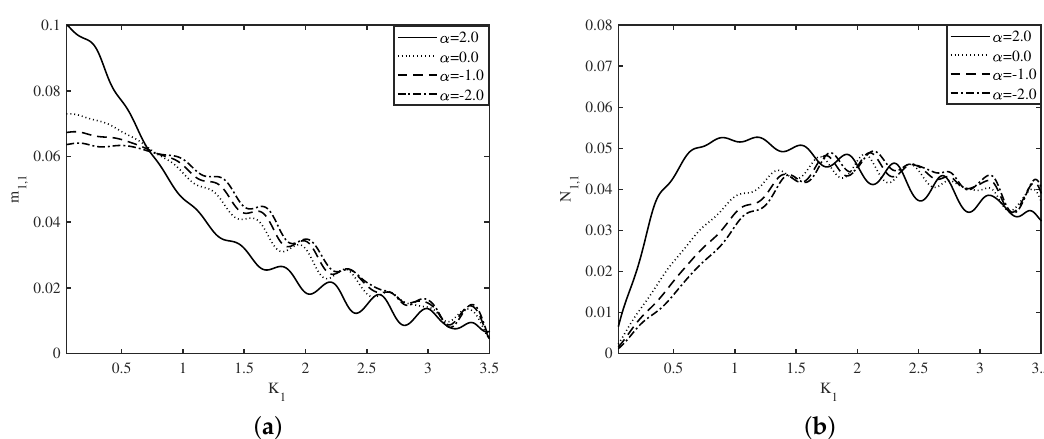
Figure 13. Variation of ( a ) m 1,1 and ( b ) N 1,1 vs K 1 for different α in type-III bed